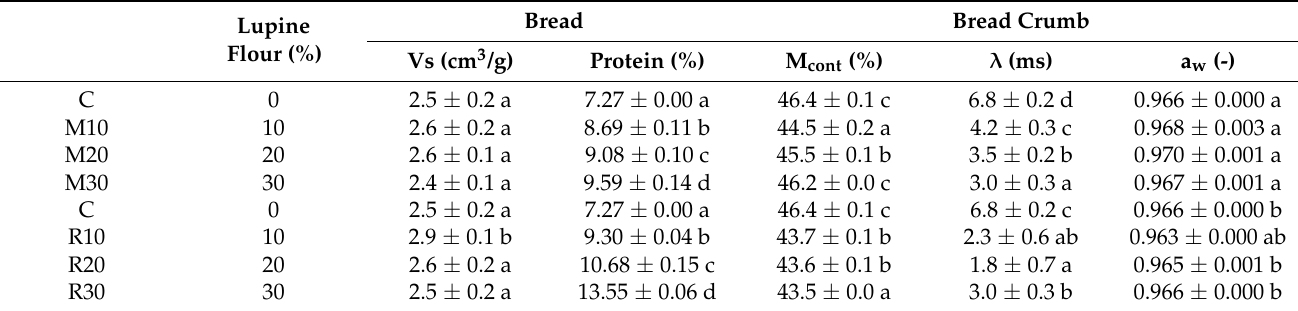
Table 3. Quality parameters of lupine wheat